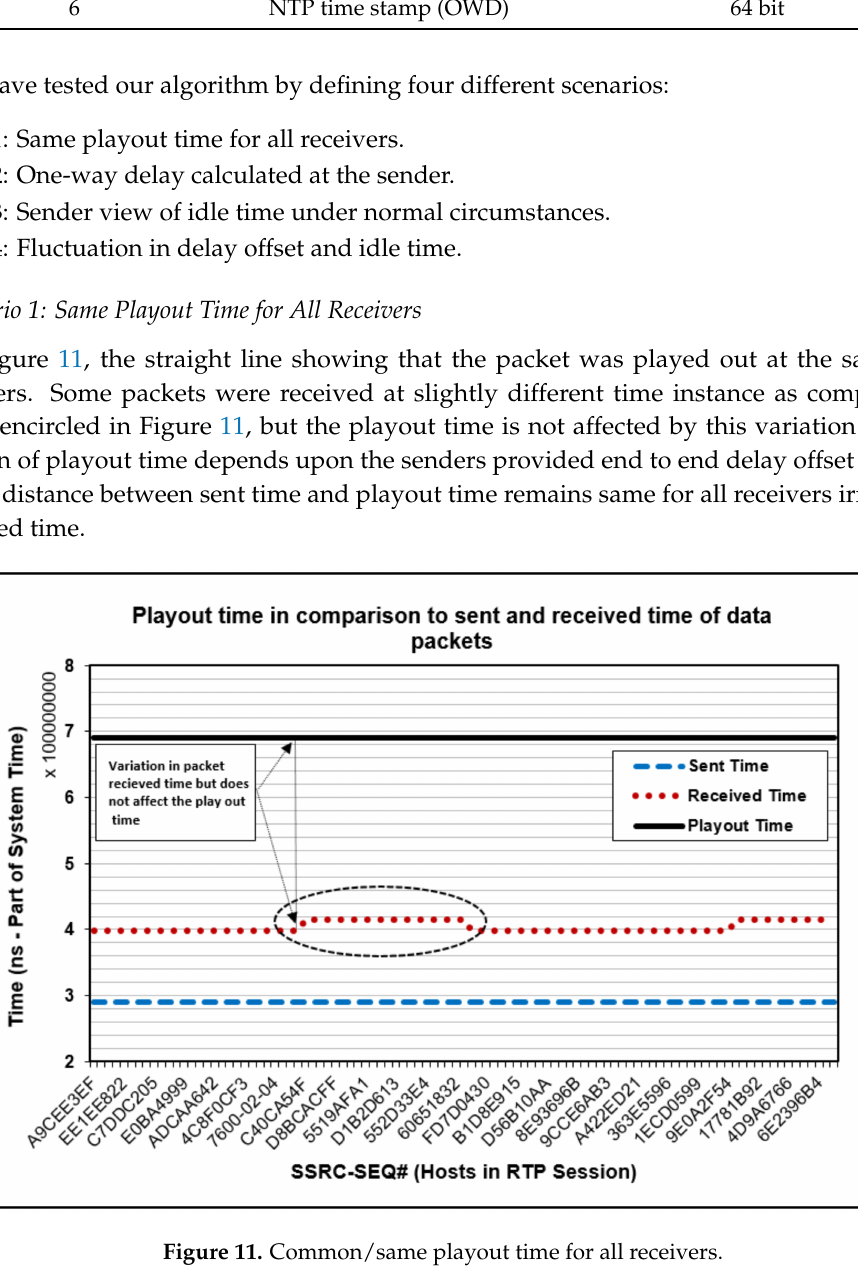
Figure 11. Common/same playout time for all